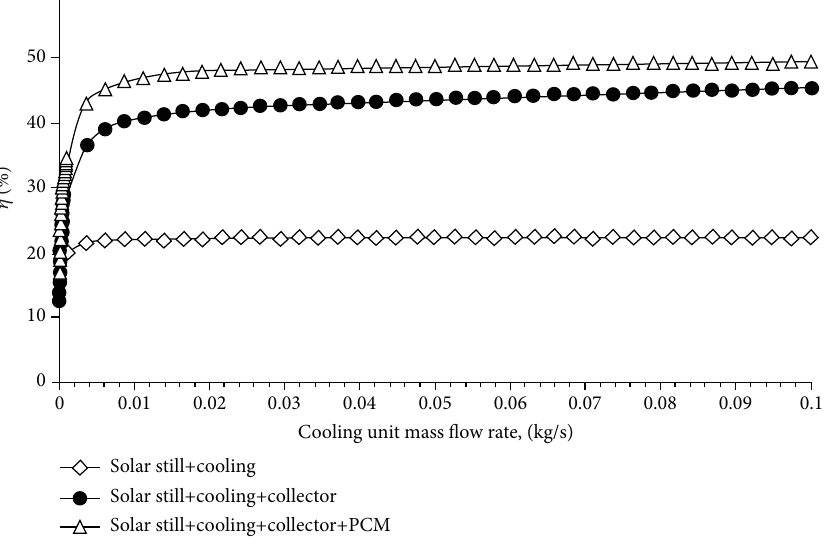
Figure 11: Cooling mass fl ow rate e ff ect on the e ffi ciency [15].